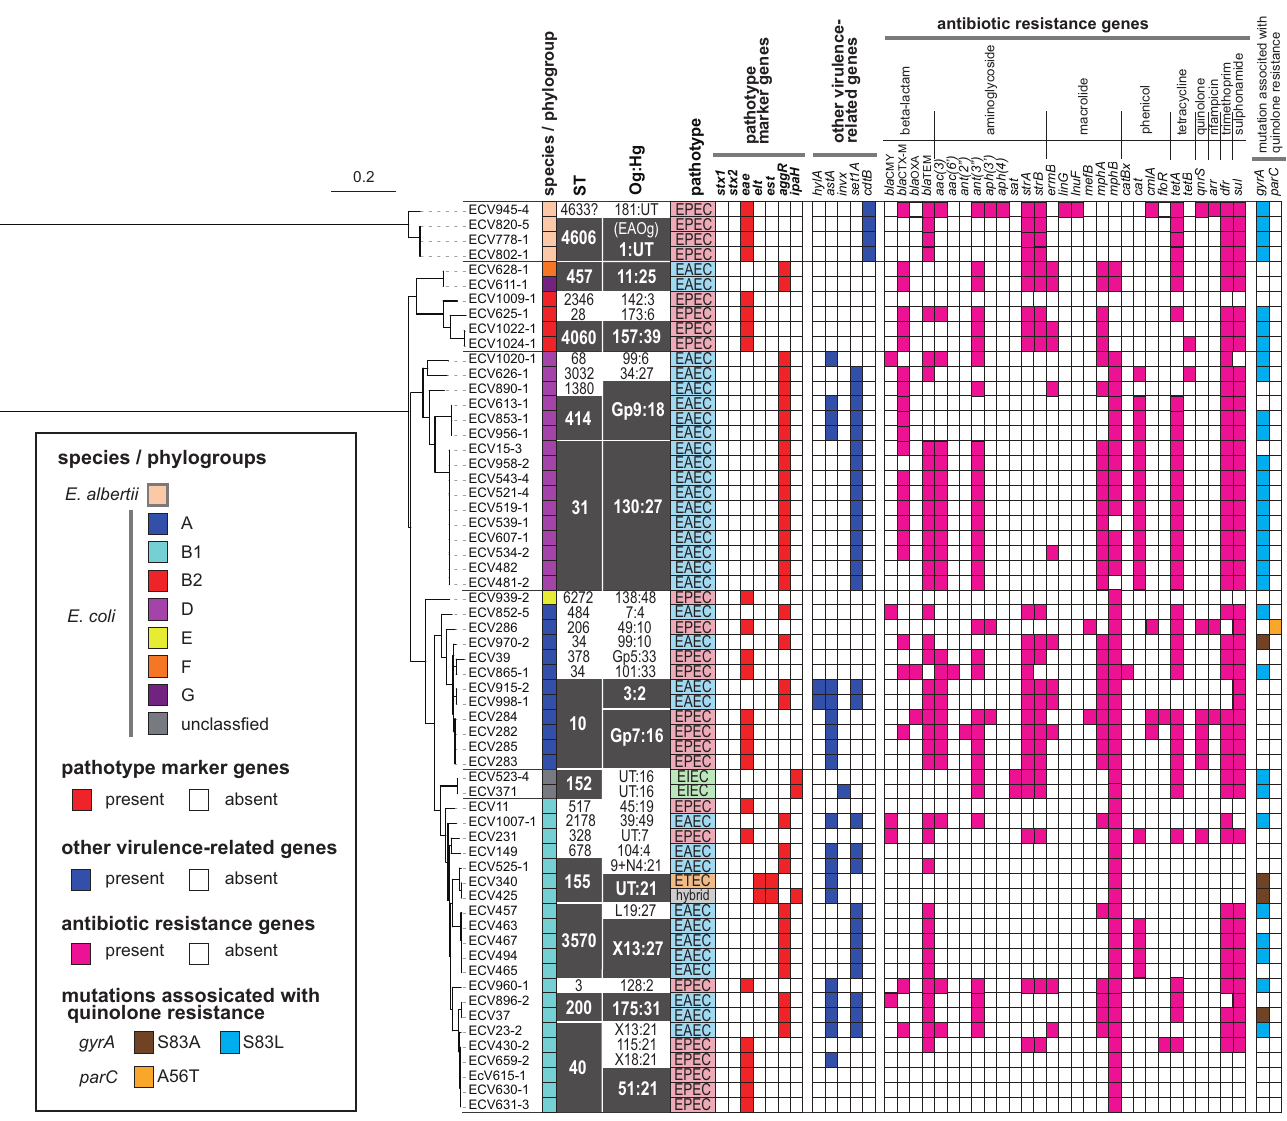
Fig 1. Phylogenetic tree, sequence type (ST), DNA-based serotype (Og:Hg), and prevalence of virulence-related and antimicrobial resistance genes/mutations. The ML tree was constructed based on 254,023 SNP sites in 2,197 core genes. Other virulence-related genes and antibiotic-resistance genes that were negative in all strains tested are not shown. An asterisk on ST indicates a single base mismatch or incomplete duplication on one gene compared to the reference sequence. UT: untypeable.